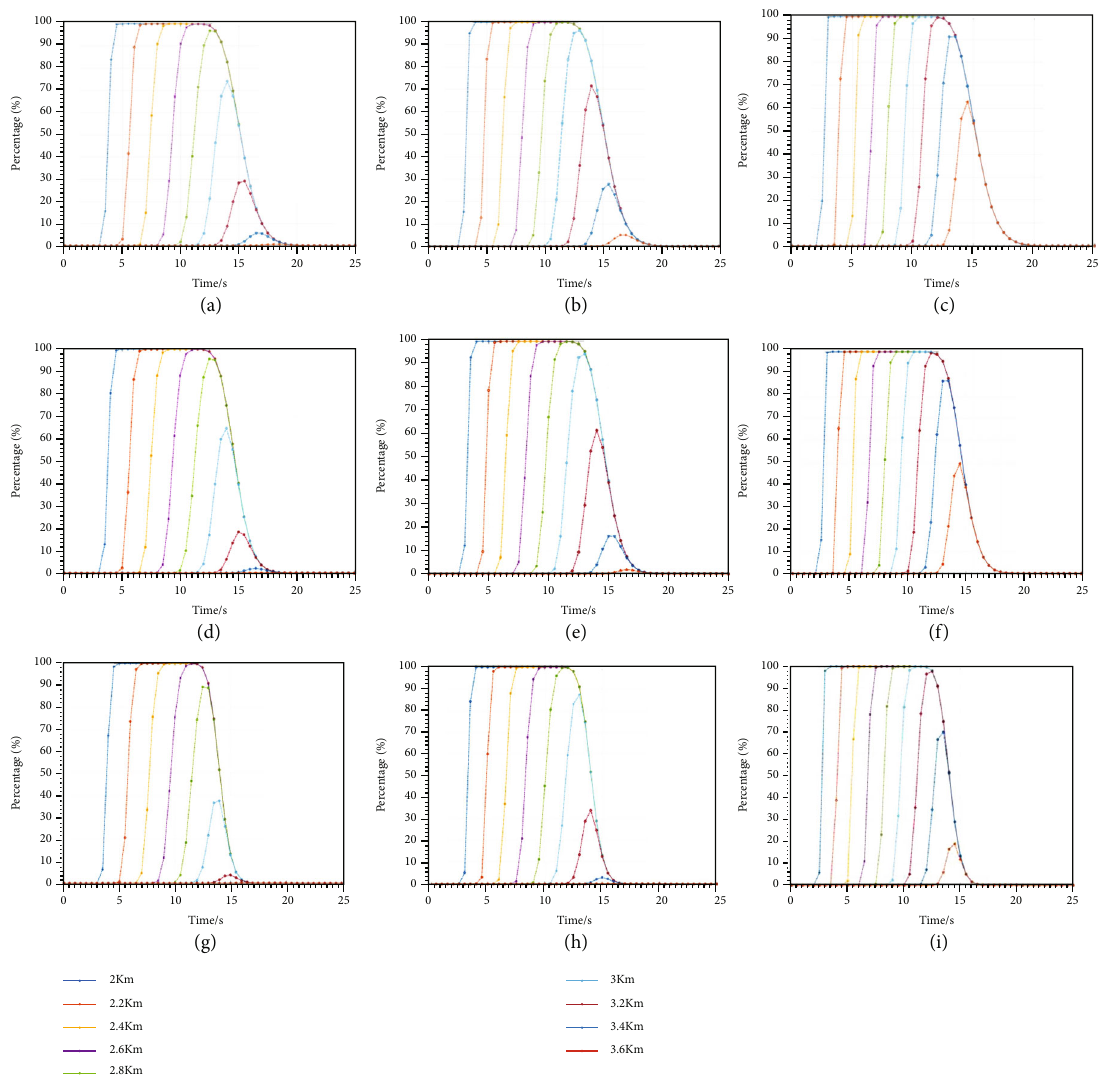
Figure 11: Con fl ict risk assessment of constant airspeed climb (MAV and UAV climbing at the same θ 1000-4200 m) versus d ∈ ½ 2, 3 : 6Km (cid:2) , H = 0 , V 1000 simulations. (a) θ = π /6 , θ = 15 π /180 ; (f) θ = π /2 , θ